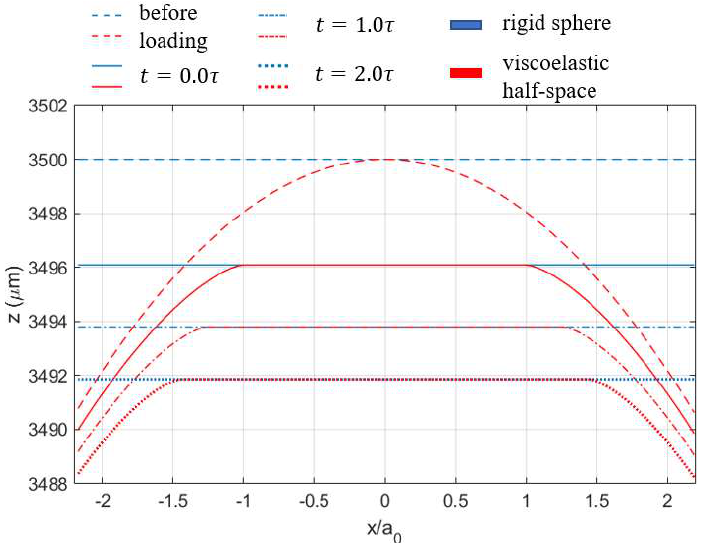
Figure 7. Geometry changes in the surface profiles at different times for the contact problem of a rigid plane indenting a viscoelastic sphere (Maxwell model) under constant normal load.